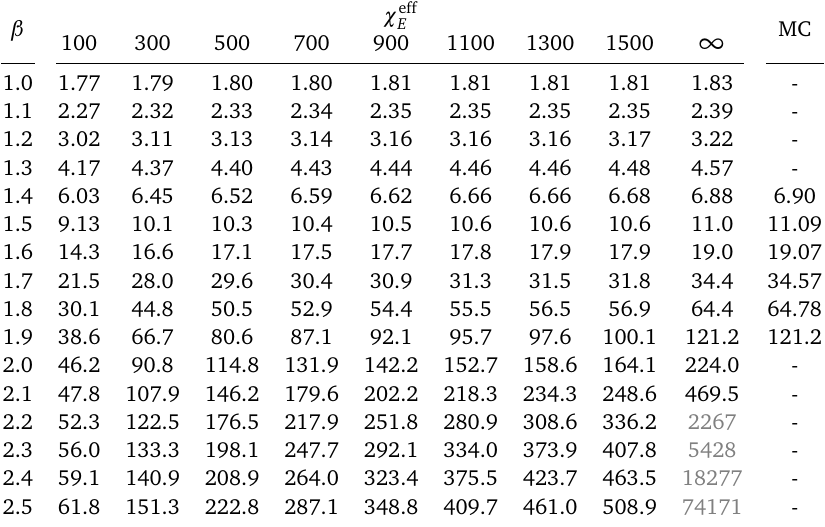
Table 2: Correlation length ξ of the boundary MPS for different values of β and χ eff at the maximal bulk bond dimension χ from the sub-dominant eigenvalue of the transfer matrix. The extrapolated values → ∞ are obtained by a finite-entanglement analysis demonstrated in Fig. 8. for χ eff E This procedure becomes unreliable for the values highlighted in gray, as discussed in the main text. Monte Carlo data from Ref. [ 85 ] is shown for comparison.